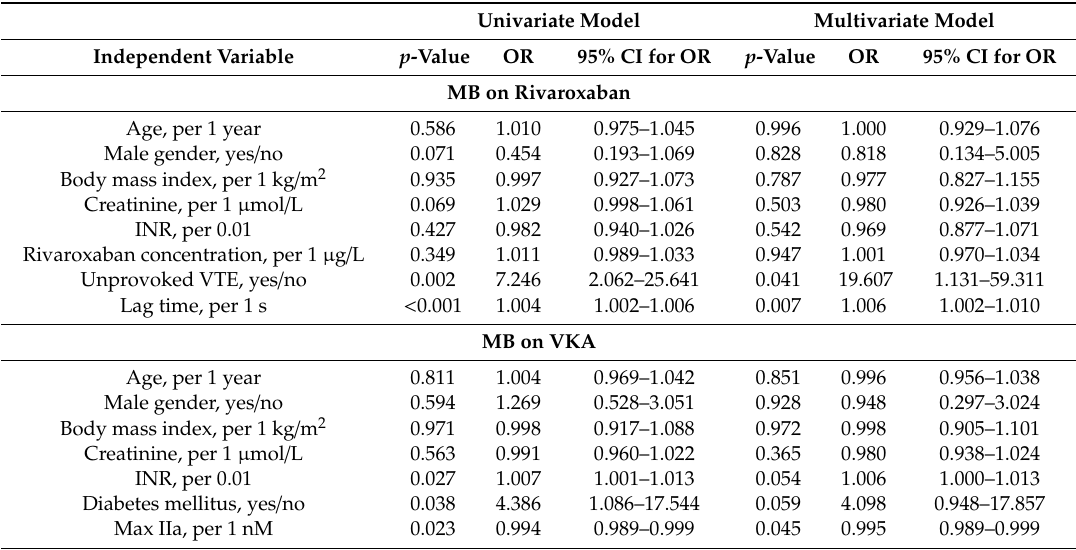
Table 2. The independent predictors of minor bleedings on rivaroxaban or on VKA. Univariate Model Multivariate